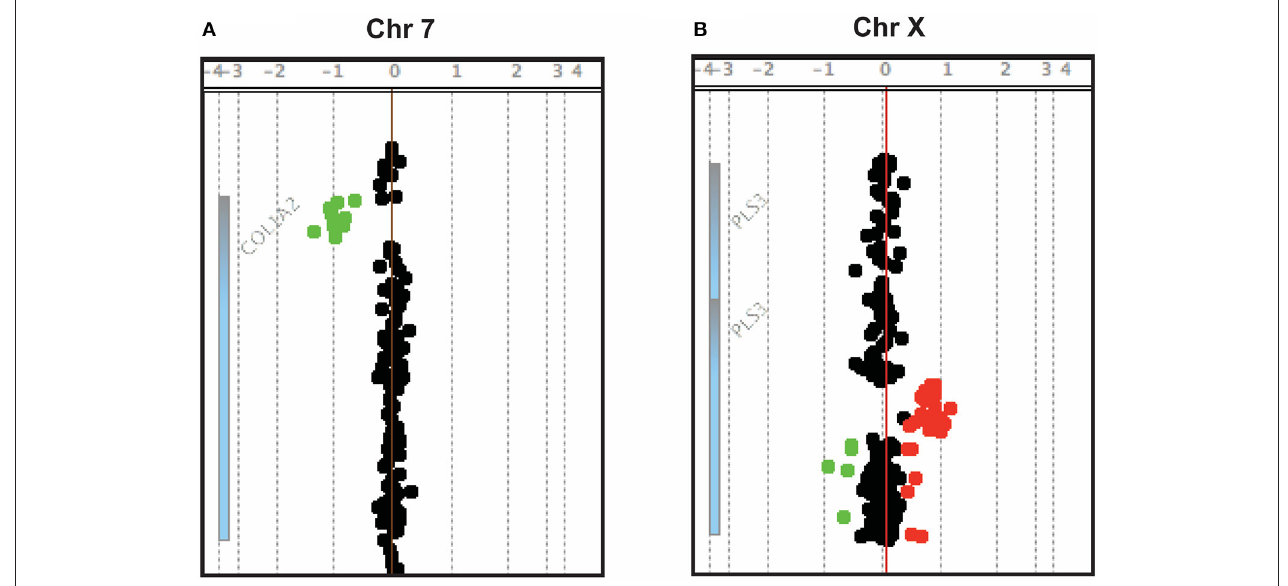
FIGURE 1 | Array-CGH snapshots showing a ∼ 4kb deletion in COL1A2 (A) and a ∼ 12.5kb duplication in PLS3 (B) .